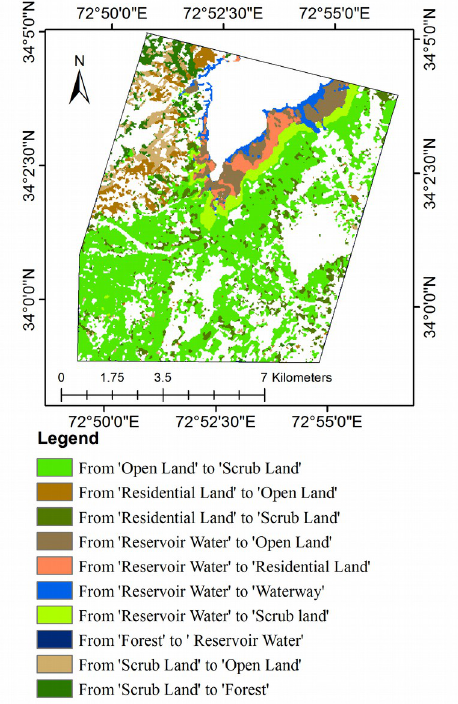
Figure 2. Winter to spring seasonal change detection